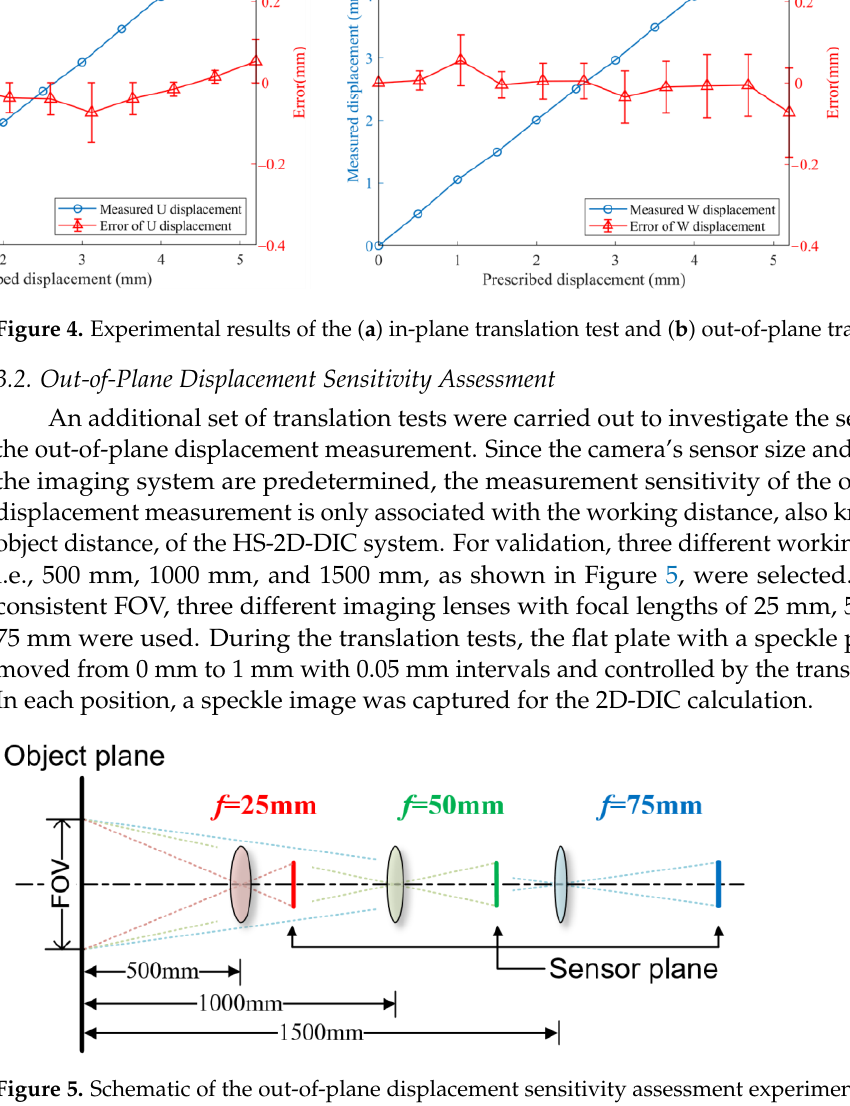
Figure 5. Schematic of the out-of-plane displacement sensitivity assessment experiment.